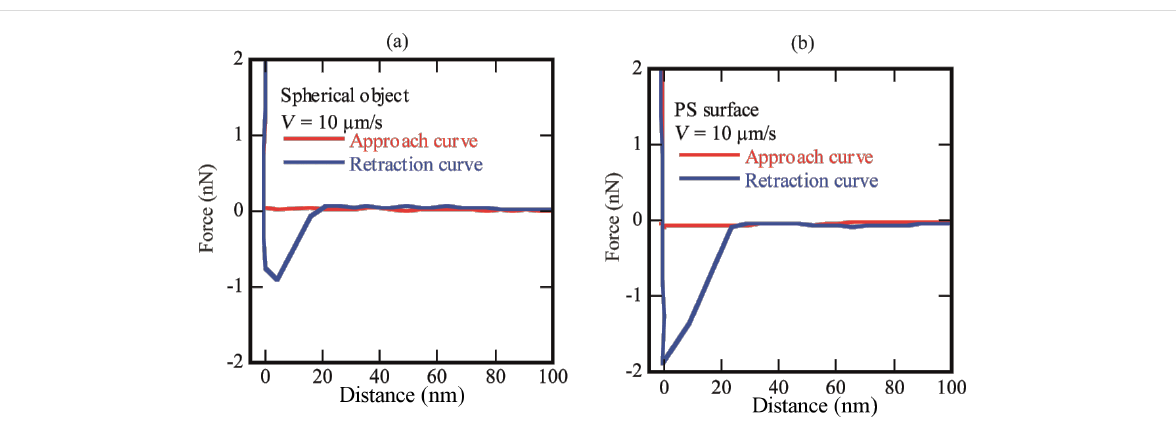
Figure 7: (a) Approach and retraction curves for a spherical object. (b) Approach and retraction curves for a PS-coated surface.